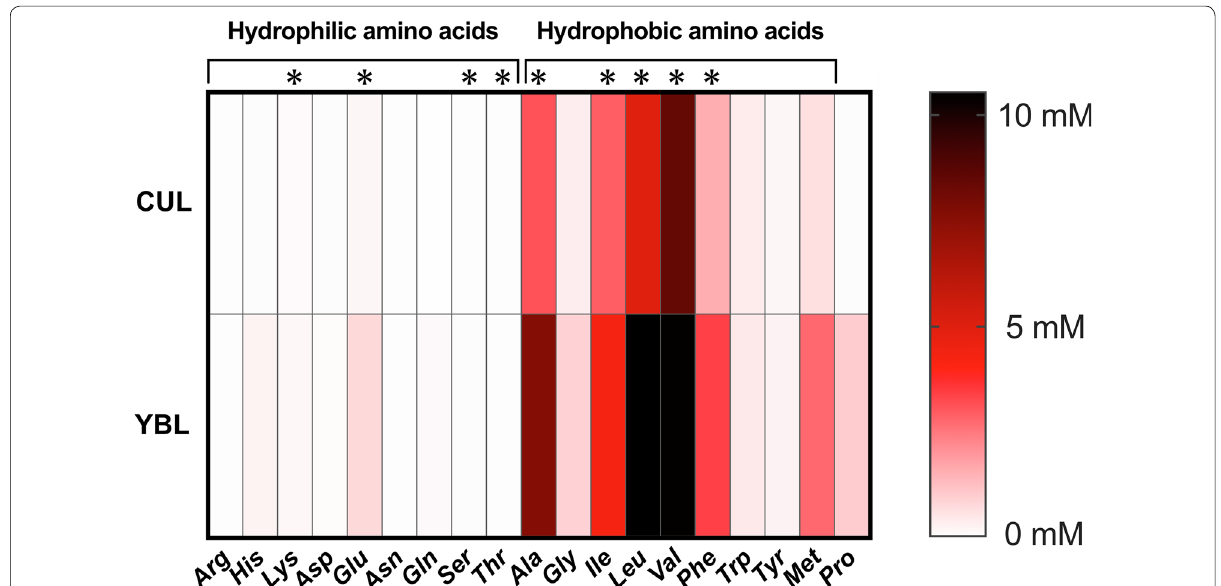
Fig. 6 Free amino acid levels in the culture supernatants. A heatmap of the average concentrations of free amino acids in the culture